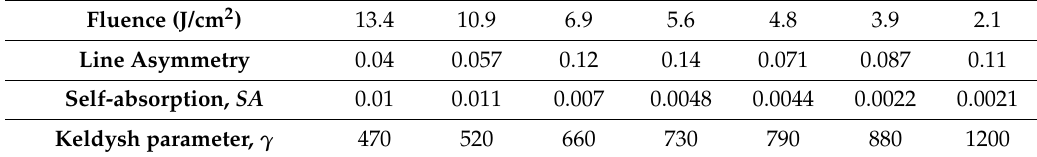
Table 2. Line asymmetries, self-absorption factors, and Keldysh parameters for different